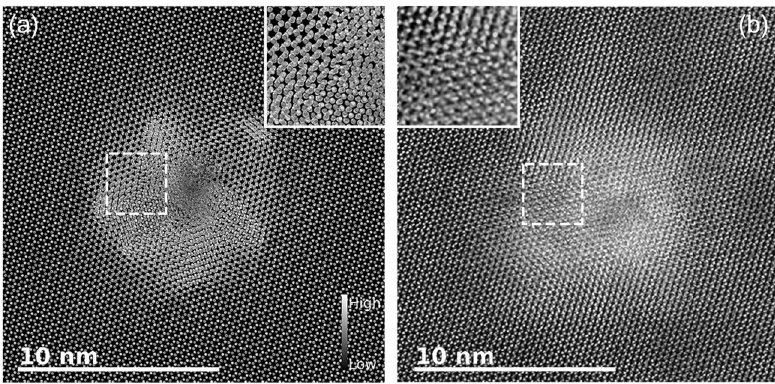
Fig. 2 Plan-view images of the fi nal track of a 185 MeV Au ion in the deeper regions. a Simulated image. b Experimental transmission electron microscopy – high-angle annular dark- fi eld image. The insets highlight the presence and similarities of the extended defects in